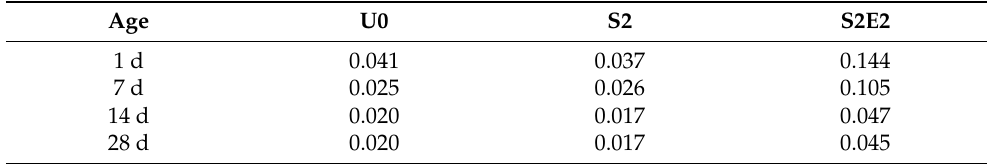
Table 9. 50~300 µ m pore volume accumulation